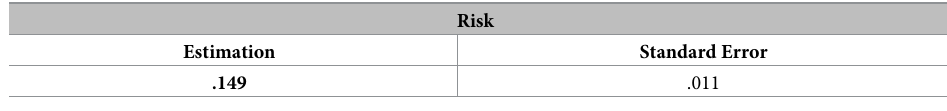
Table 2. Table of model classification.